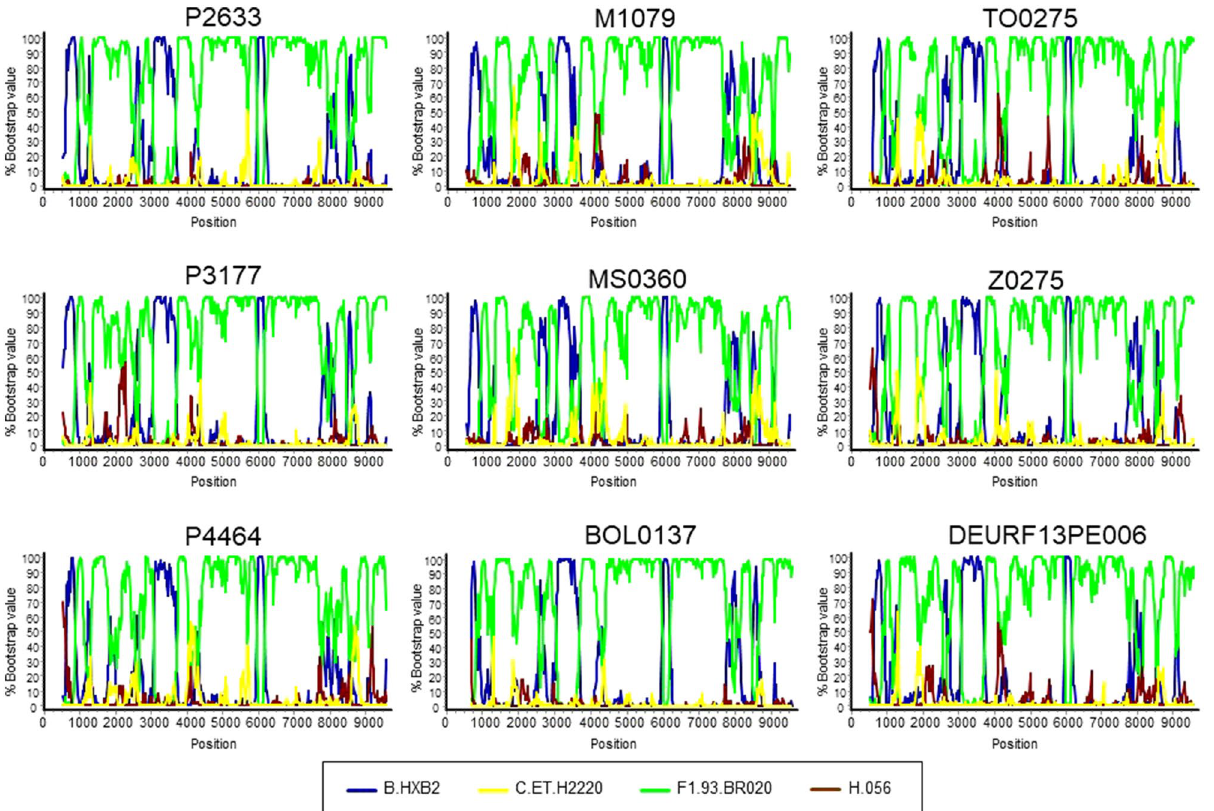
Figure 3. Bootscan analyses of 9 NFLG genomes of the BF cluster. The horizontal axis represents the position in the HXB2 genome of the midpoint of a 250 nt window moving in 20 nt increments and the vertical axis represents bootstrap values supporting clustering with subtype reference